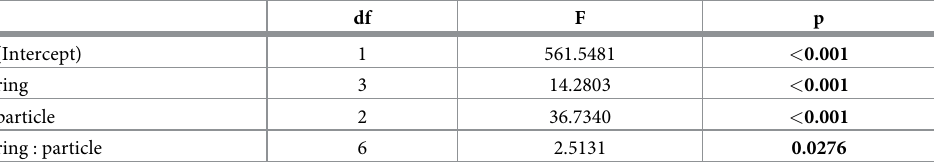
Table 1. Results of two-factors ANOVA (ring / horizontal distance and particle / biochar type). Significant p-val- ues < 0.05 shown in bold. df F p (Intercept) 1 561.5481 ring 3 14.2803 particle ring :